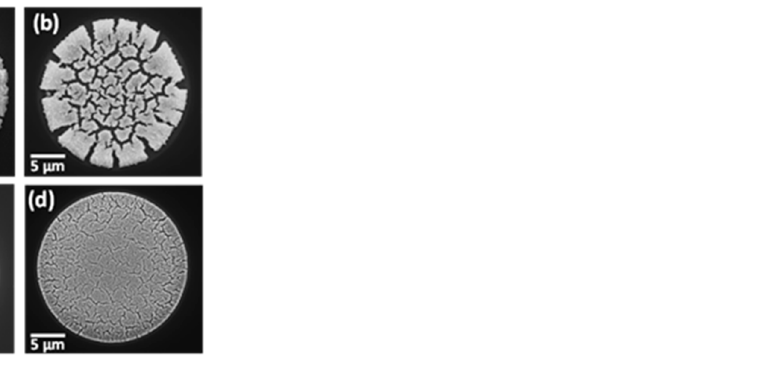
Figure 10. Plan view SEM images of a NPG-modified microdisc following ( a – d ) 30, 10, 5 and 3